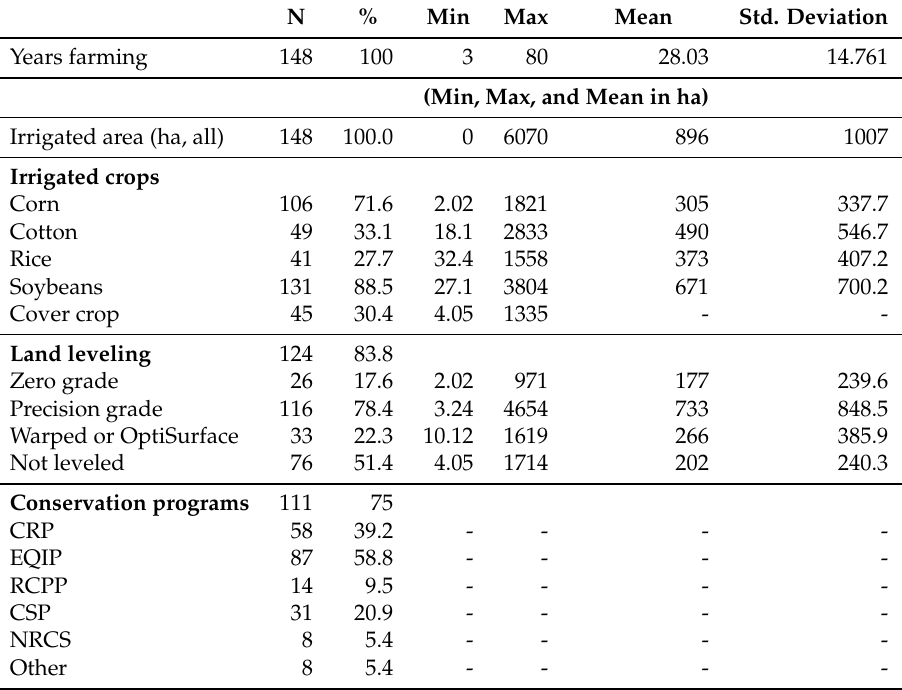
Table 2. Summary statistics of cultural